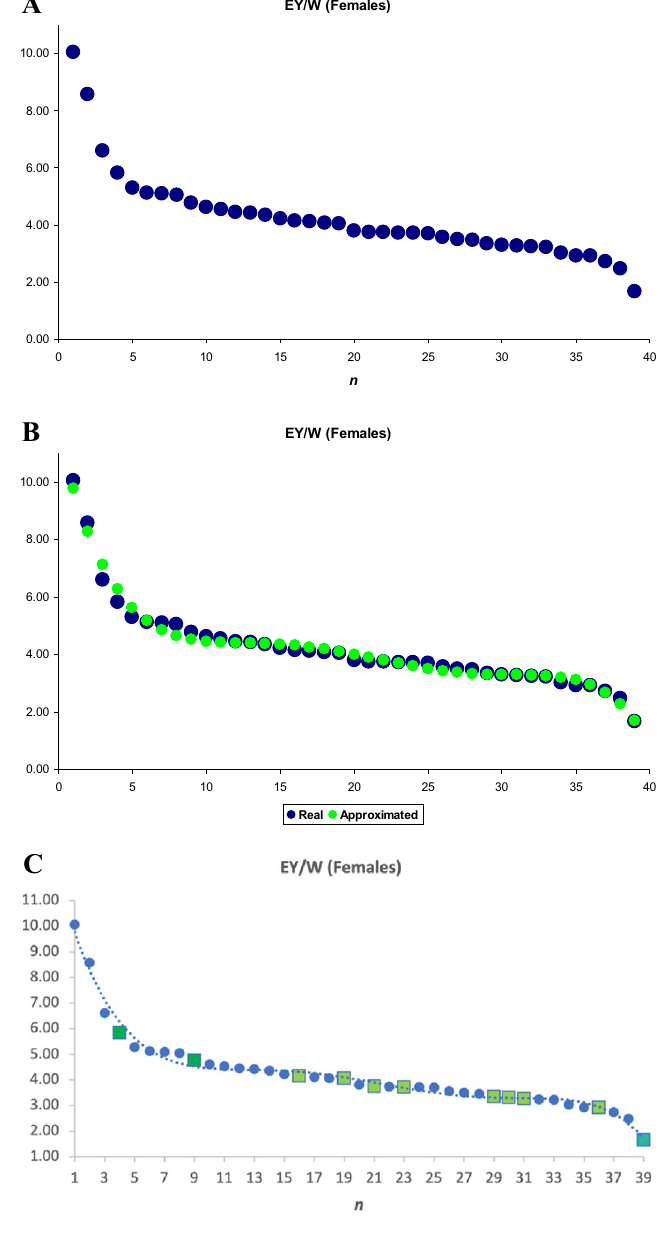
Figure 3. Graph of change in mean EY / W values in females of the 39 chicken breeds studied. ( A ) original dataset; ( B ) correspondence of the approximated dependence (green trendline) to actual data (blue curve); and C original dataset including the respective trendline (blue dotted lines) and 11 core breeds (filled green square). EY / W , integral performance index as a ratio of egg mass yield ( EY ) and female body weight ( W ); n (1 to 39; see Table 1), conditional serial numbers assigned to breeds of chickens according to the degree of descending EY / W